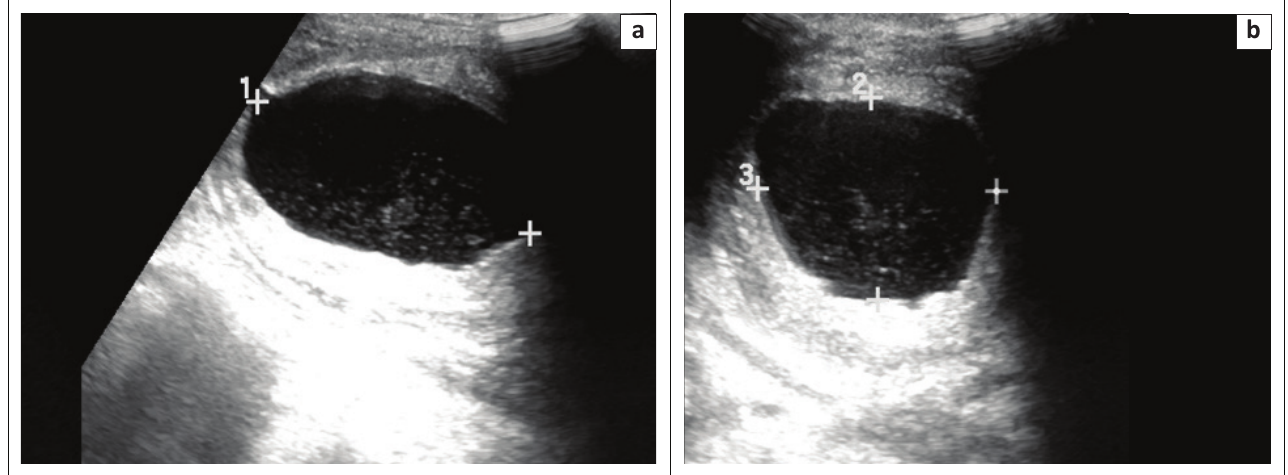
FIGURE 1: Ultrasound images of the bladder in the sagittal planes (a) and transverse (b) indicate multiple intravesical low-level echoes. These were mobile on real time B-mode scan.